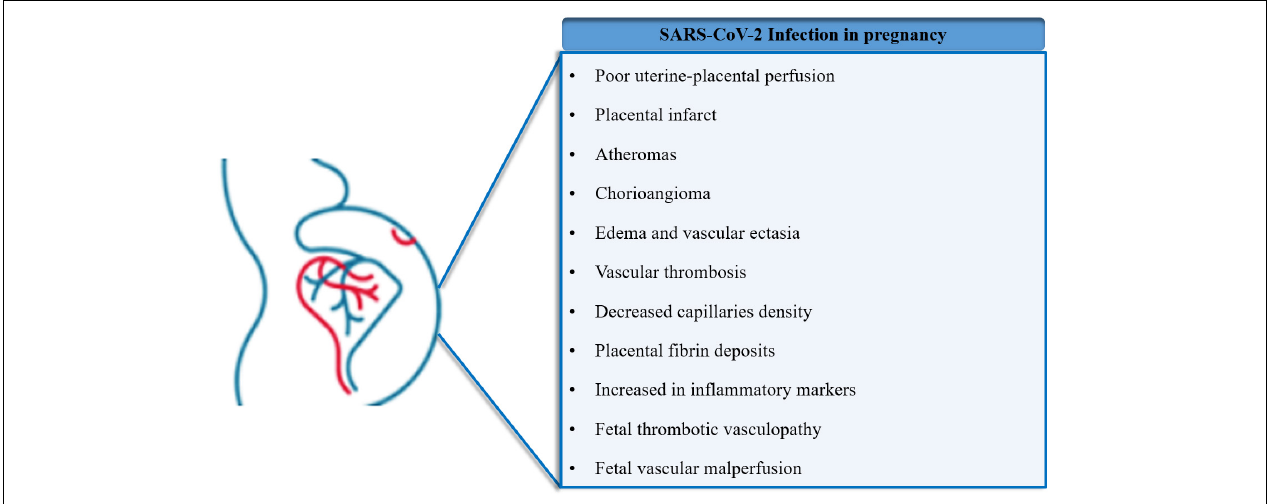
FIGURE 4 | Major placental and gestational disorders associated with Severe Acute Respiratory Syndrome Coronavirus 2 (SARS-CoV-2). Pregnant women constitute a population group with special conditions due to the imminent risks to the mother and fetus. Recent evidence has shown that SARS-CoV-2 infection during pregnancy results in distinct physiological alterations, affecting placental function and distinct gestational parameters.